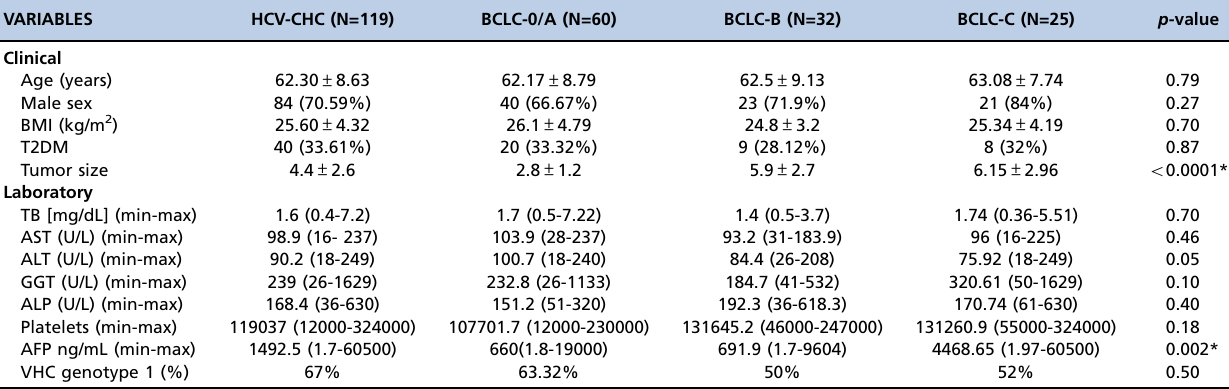
Table 1 - Clinical and laboratory characteristics of Brazilian patients with HCV-related HCC, according to the BCLC (Barcelona Clinic Liver Cancer) classification.